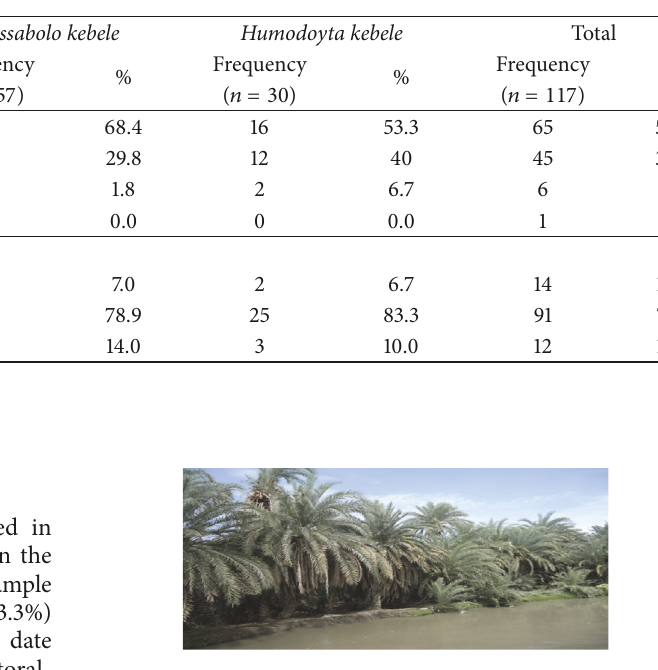
Table 3: Production area allocated and experience of date palm production in the study area.